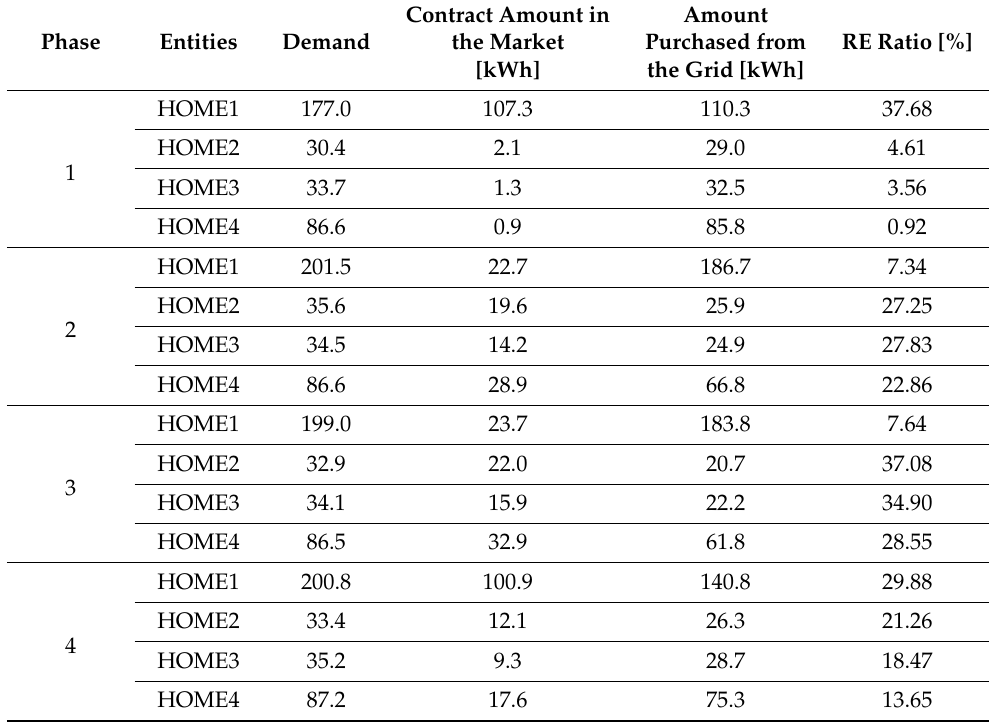
Table 5. RE ratio of each demand-side user per experimental phase.